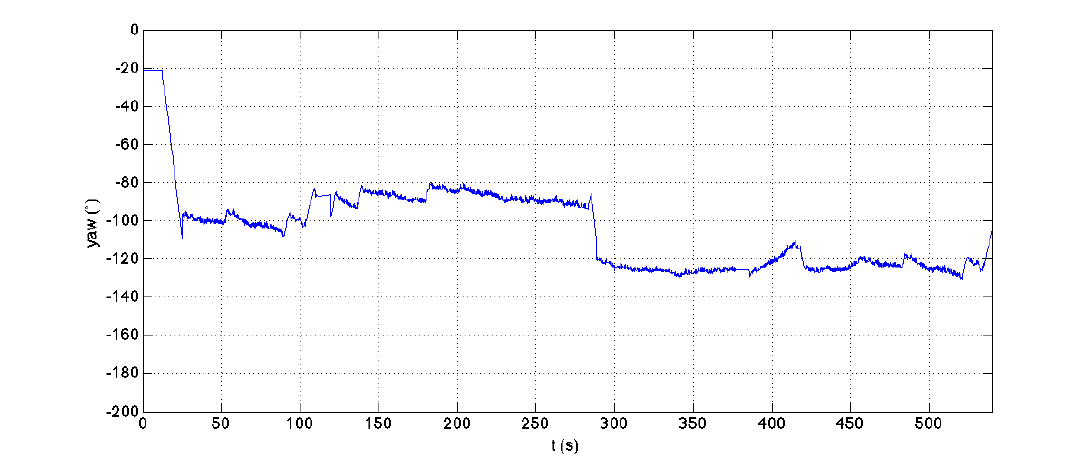
Figure 17. Yaw variations during the